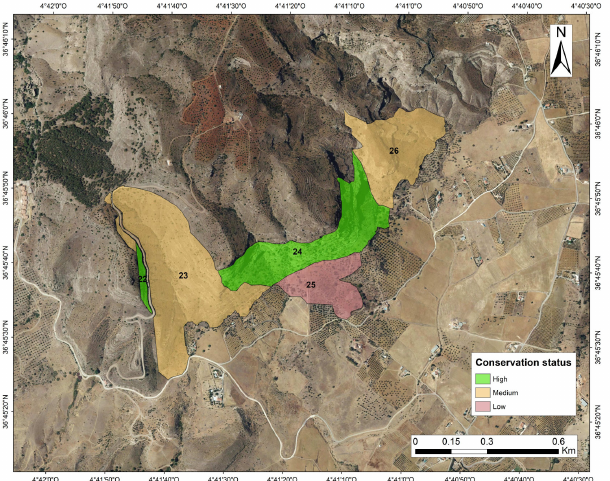
Figure 6. Pizarra locality cartography. The color indicates the degree of conservation (DC) of the 5220* HCI at each polygon number: the green color indicates an excellent degree of conservation; the orange color means a good degree of conservation; and the red color corresponds to a reduced degree of conservation. The enumeration of the polygons follows Table 2. The base map used is the World Imagery, provided by ESRI [52]: layer services credits source: Esri, Maxar, GeoEye, Earthstar Geographics, CNES/Airbus DS, USDA, USGS, AeroGRID, IGN, and the GIS User